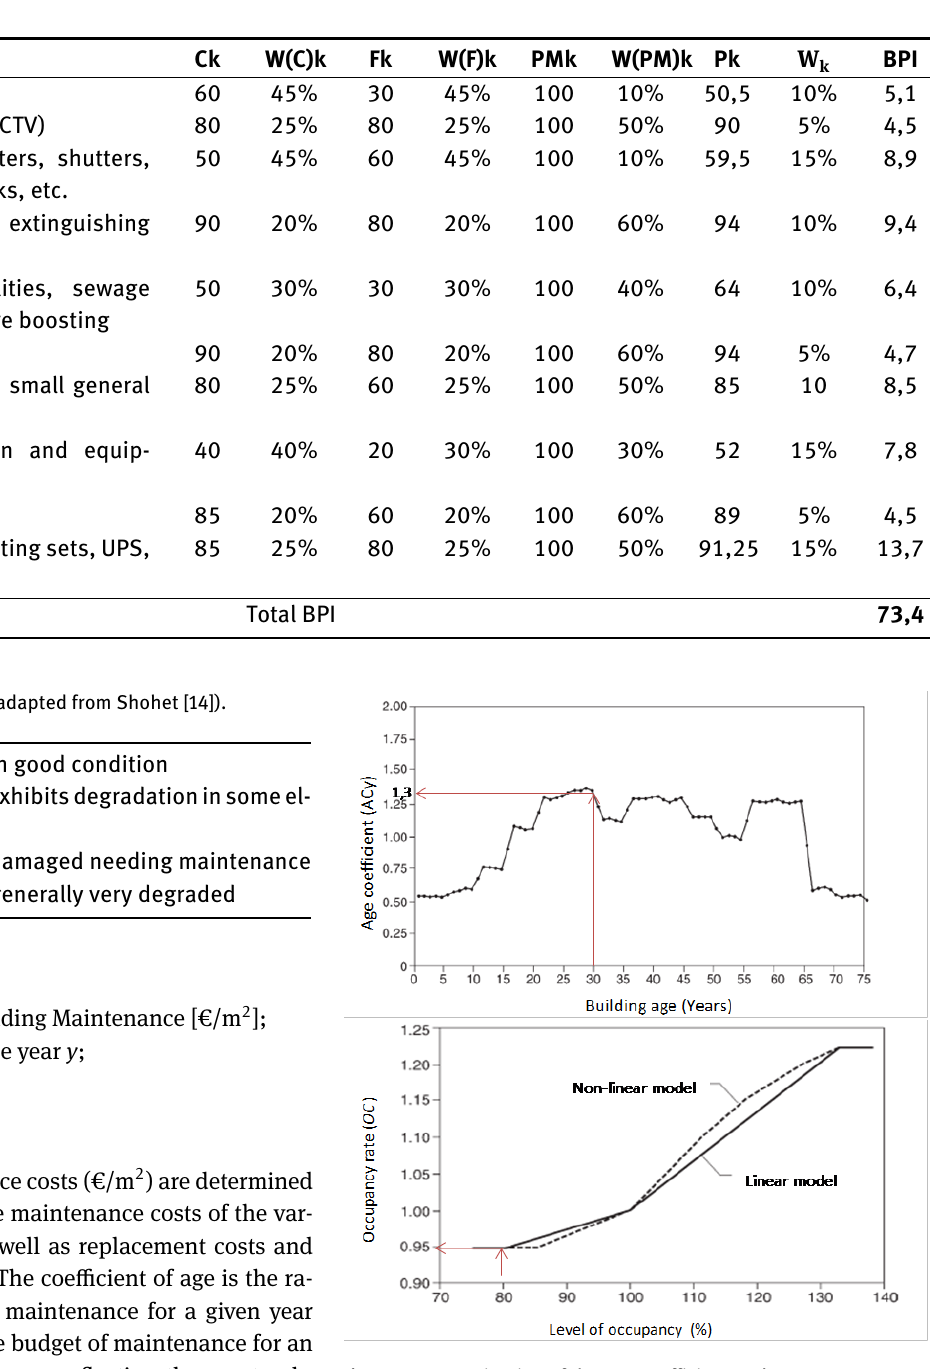
Table 6: BPI calculation.